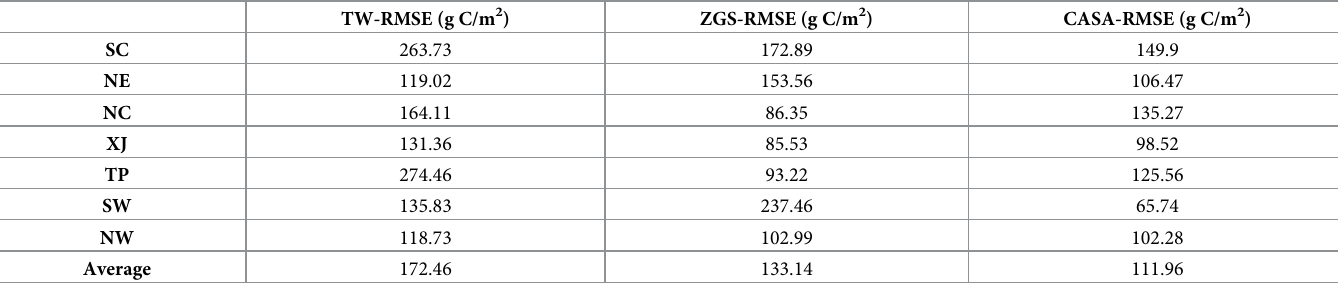
Table 3. RMSE of three models comparable with MODIS NPP product.